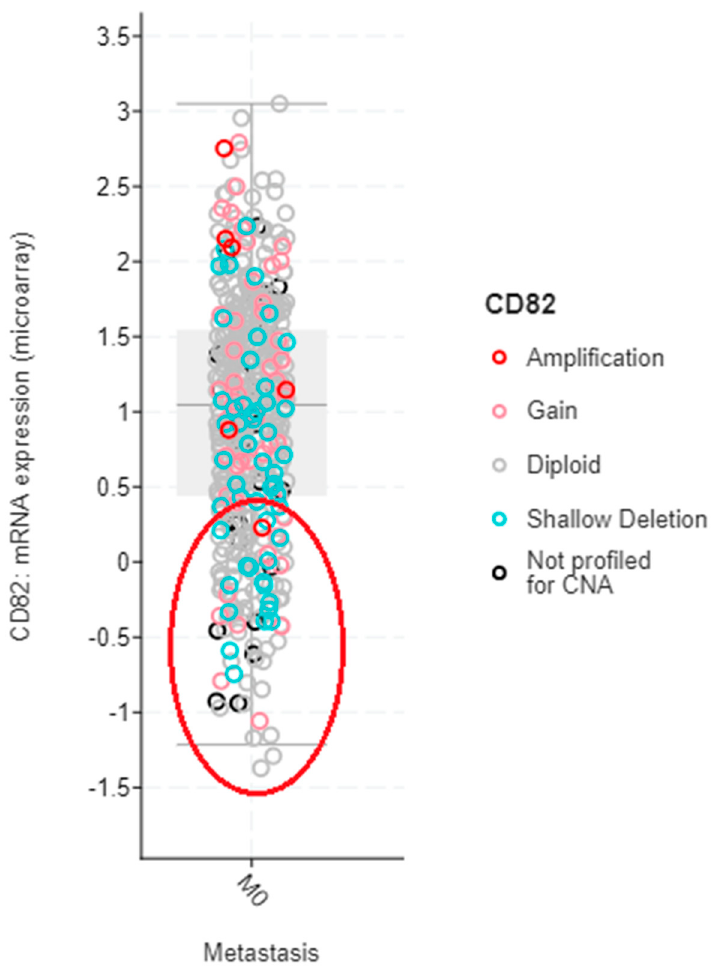
Figure 3. Box plot showing expression of CD82 in primary breast cancer tissues ( n = 519) as derived from the cBioPortal database [72,73]. Datasets in the cBioPortal database are obtained from multiple sources, including Memorial Sloan Kettering Cancer Centre (MSKCC), Duke University–National University of Singapore (Duke-NUS), Samsung Medical Centre (SMC) and The Cancer Genome Atlas (TCGA), among others. The encircled region (delineated by the red oval) represents breast cancer cases with low expression of CD82.